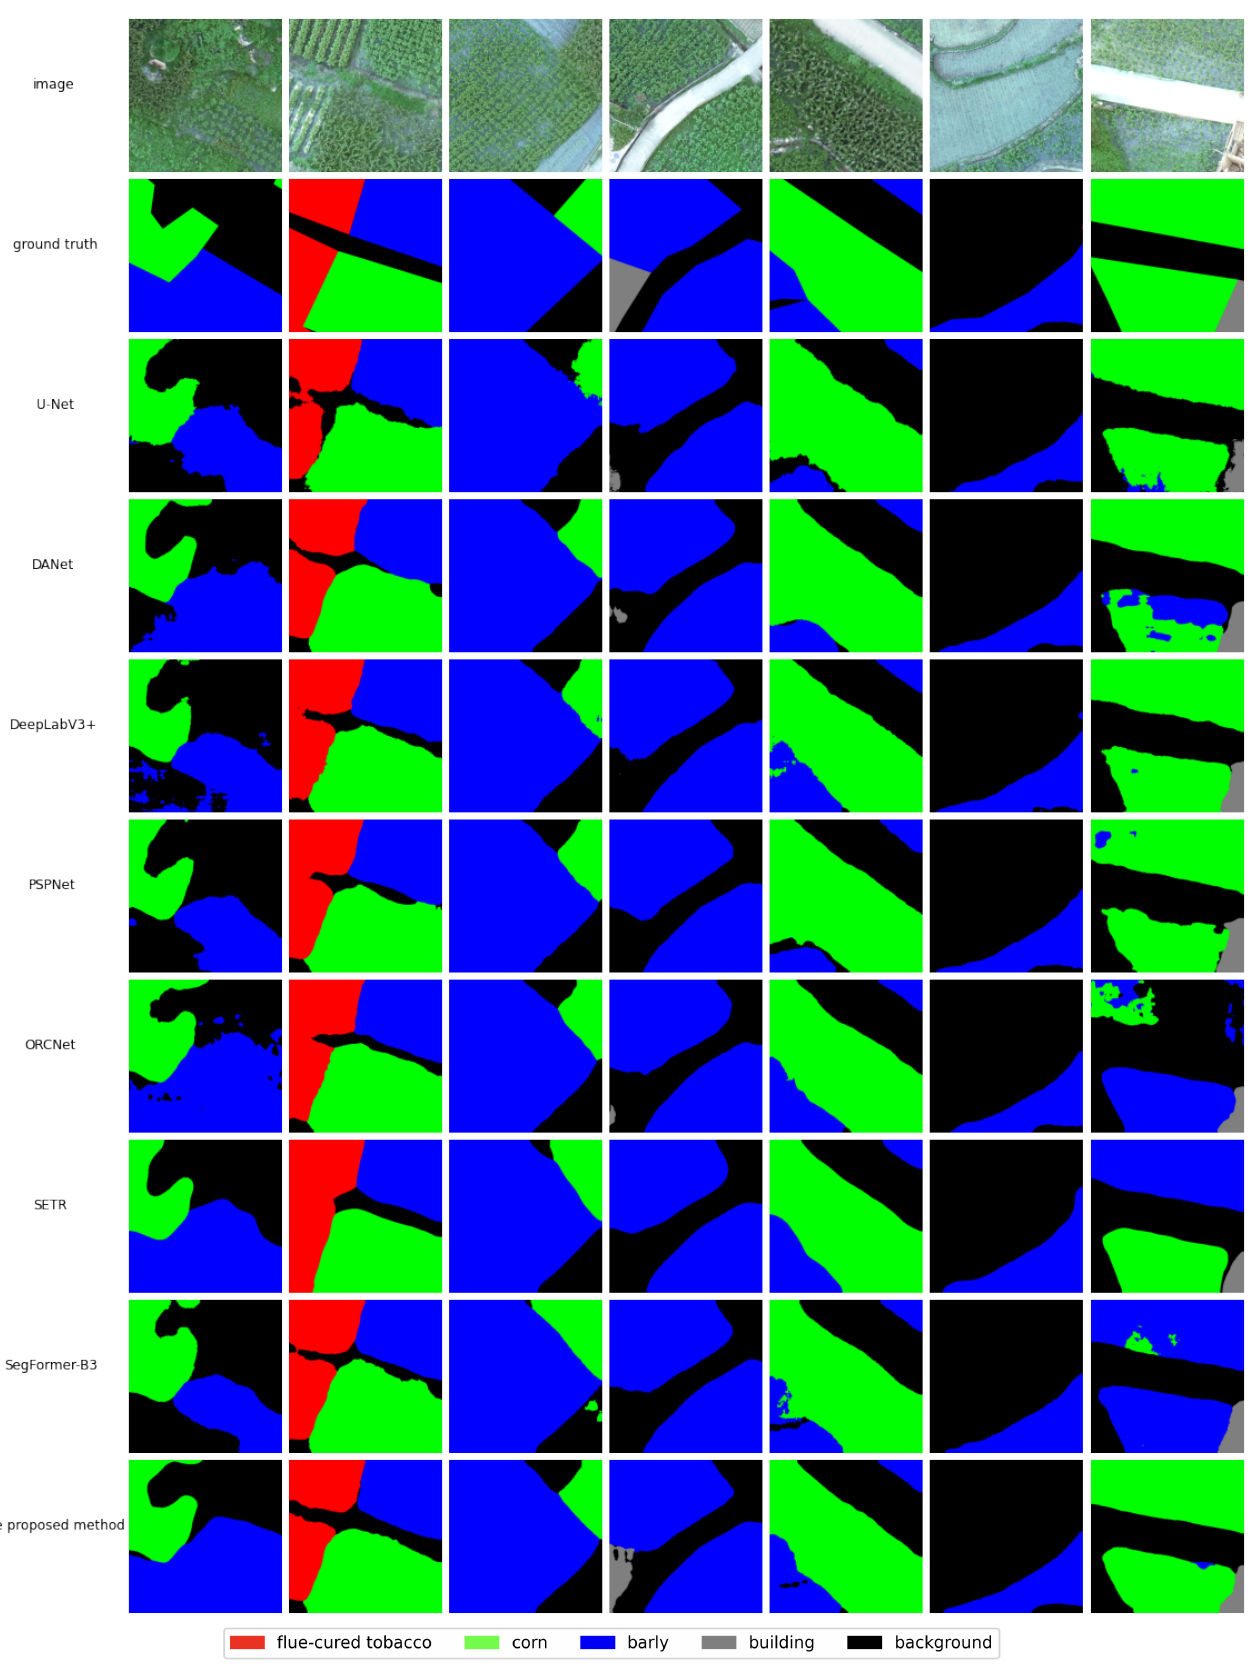
Figure 6. Examples and comparison of crop-type segmentation